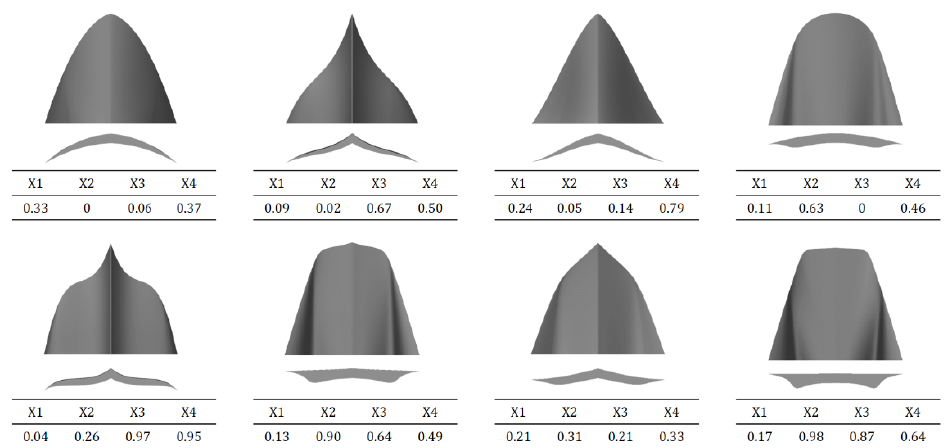
Figure 7. Examples of waverider configurations with various design parameters: M ∞ = 5, β = 15 ◦ , width = 3 m, and height = 1.34 m